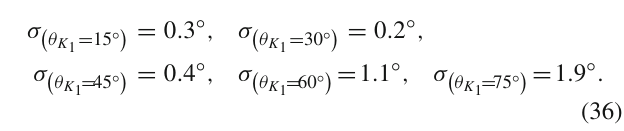
Fig. 2 The K πππ invariant mass distribution of the τ − → K − ( K − ω)ν τ → ( K − π + π − π 0 )ν τ after taking into account the detector effect of